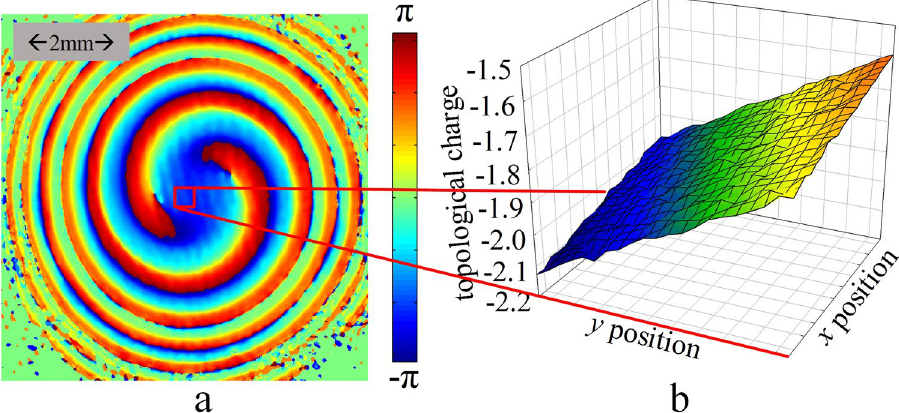
Figure 5. ( a ) The phase distribution of the objective beam carrying OAM of l = − 2, and the red box section denotes the boundary of the reference axes adopted to calculate the topological charges. ( b ) The topological charges calculated with different reference axes (21 × 21 axes are chosen to reduce the fluctuations) and the x-y coordinate denotes the position of reference axes while the vertical coordinate denotes the corresponding topological charge.